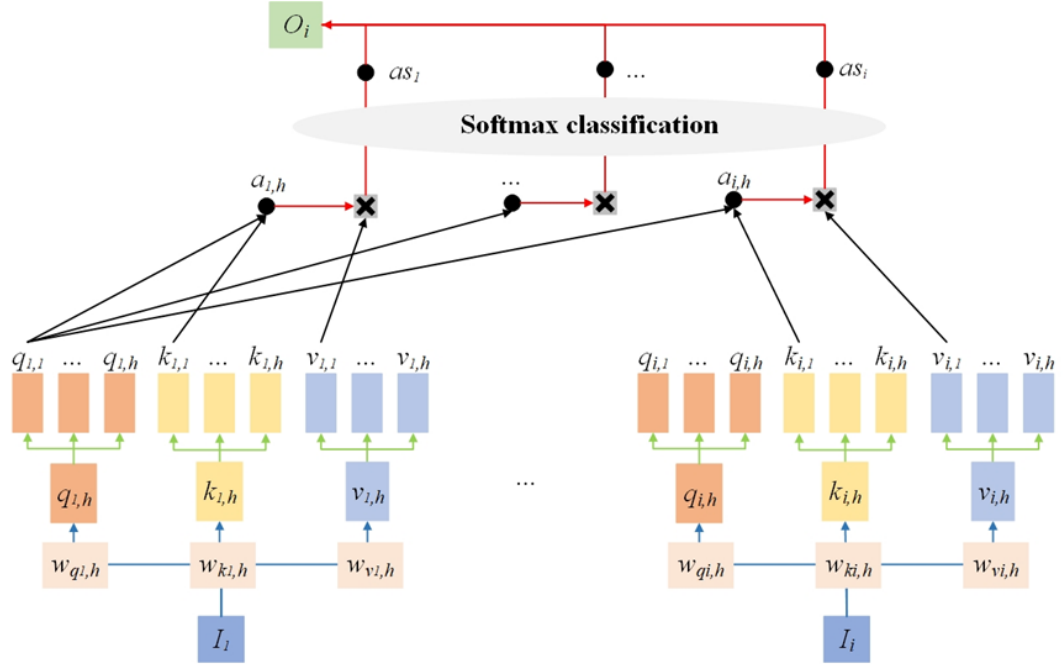
Figure 2. Architecture of self-attention-enhanced region proposal extraction layer.